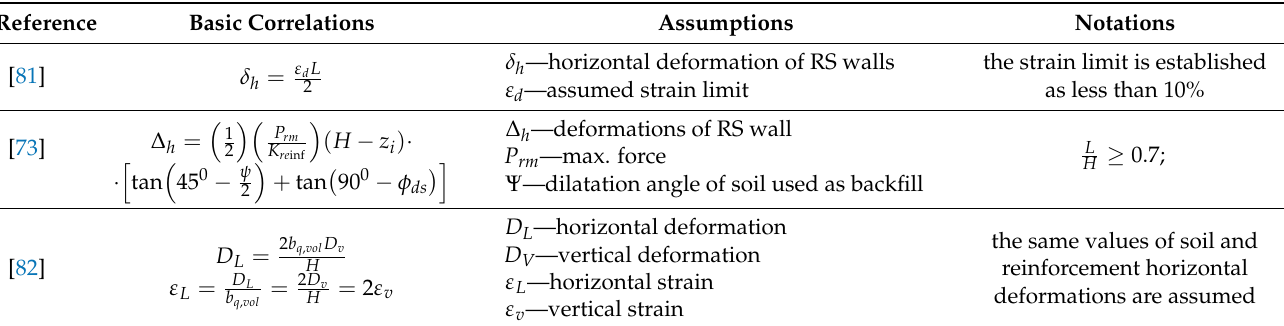
Table 1. Short description of the most popular analytical methods used to calculate the horizontal deformations of reinforced soil